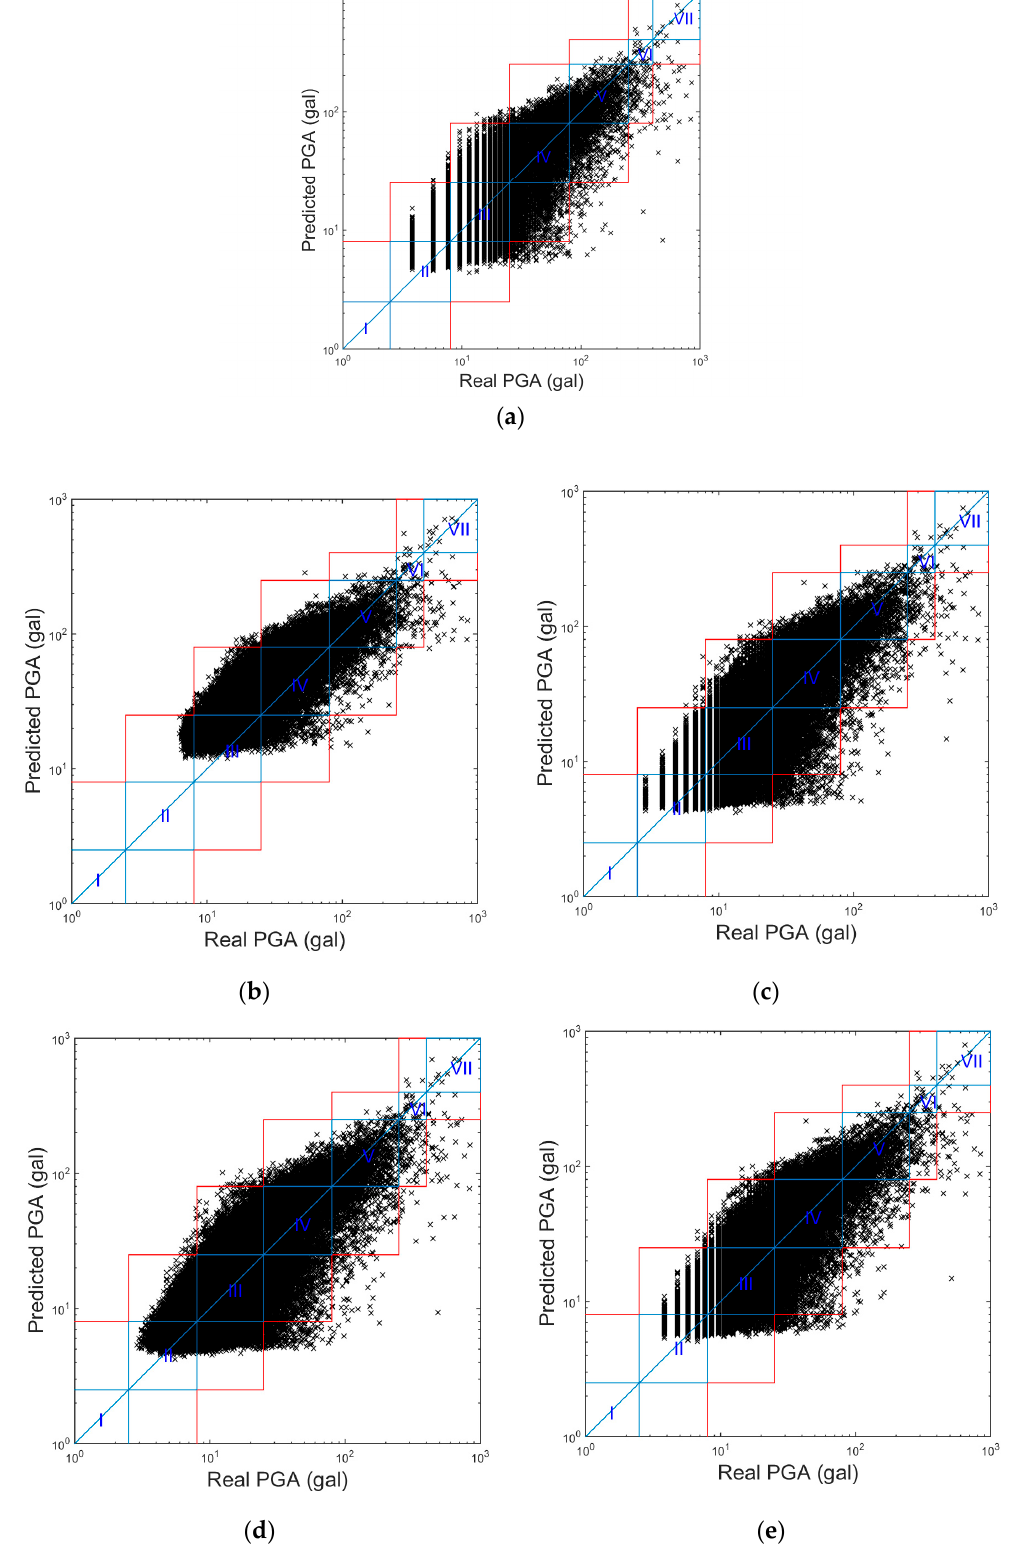
Figure 2. The comparison of the predicted PGA values of the typical 3 s prediction model (LG Stylus) with the real PGA values using smartphone ( a ) LG Stylus; ( b ) Asus ZenFone Selfie; ( c ) HTC Desire Eye; ( d ) Redmi Note4; ( e ) Huawei P3.